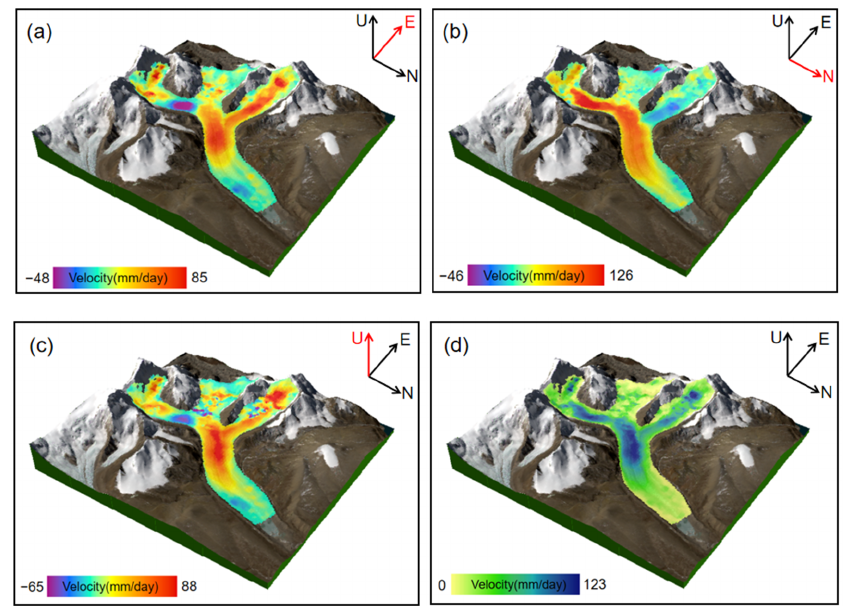
Figure 6. Results of the three-dimensional displacement rate of glacier surface: ( a ) west–east; ( b ) north–south; ( c ) vertical; ( d ) after the synthesis. The superimposed background is a 3D model from Landsat 8 images combined with DEM in the study area. The upper part of the glacier has reached 6588 meters, with several steep peaks. White shows the snow and glacier-covered area.